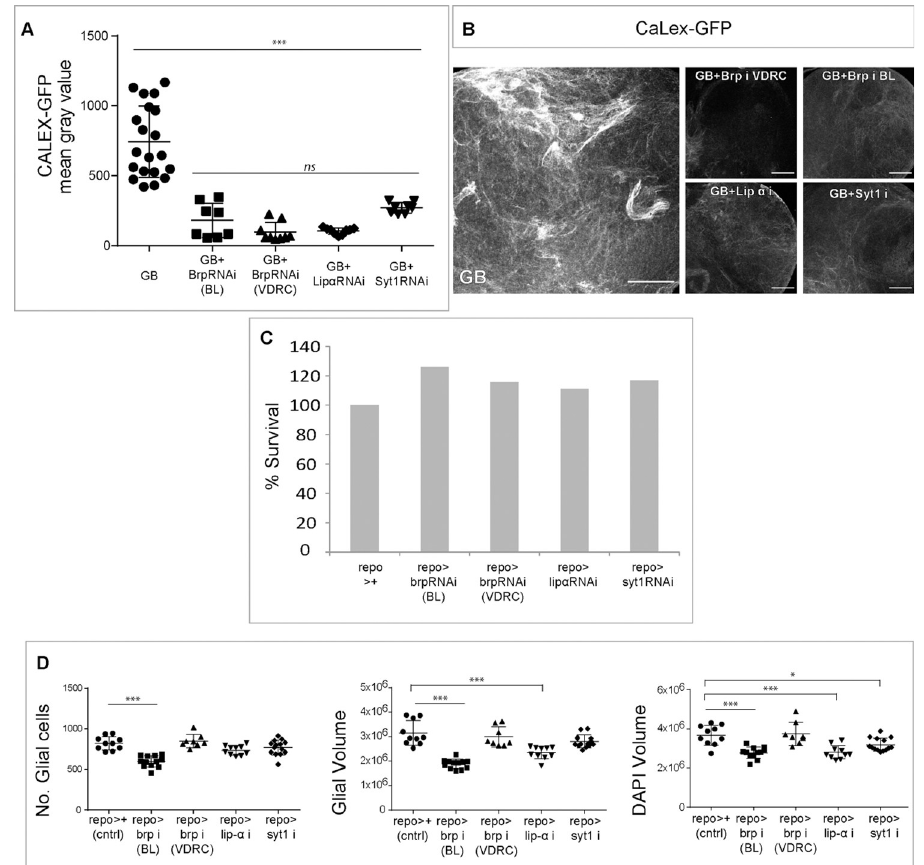
Fig 4. Presynaptic proteins are required for Calcium influx in GB. A) Quantifications of CaLexA signal in GB brains, and GB brains upon presynaptic genes brp , syt 1 or lip- α knockdown by RNAi. No. � 8 brain lobes. Statistics: Bonferroni’s Multiple Comparison Test ( ��� p < 0.0001, ns = non-significant). B) Representative confocal images of CaLex signal in GB brains, and GB brains upon presynaptic genes brp , syt 1 or lip- α knockdown by RNAi. C) Histogram showing the viability of control flies (100%) compared with flies where brp (134.26% and 108.5%), lip (121.26%) α or syt 1 (103.19%) are downregulated in normal glia. No. � 106 animals. D) Quantification of the number of glial cells, glial membrane volume and DAPI volume, per larval brain lobe in controls, and animals where brp , lip α or Syt 1 are downregulated in glia. No. � 8 brain lobes. Statistics: Dunnett’s Multiple Comparison Test ( ��� p < 0.0001, � p < 0.005). Scale bars: 50 μ m. Raw numbers and complete genotypes are in S1